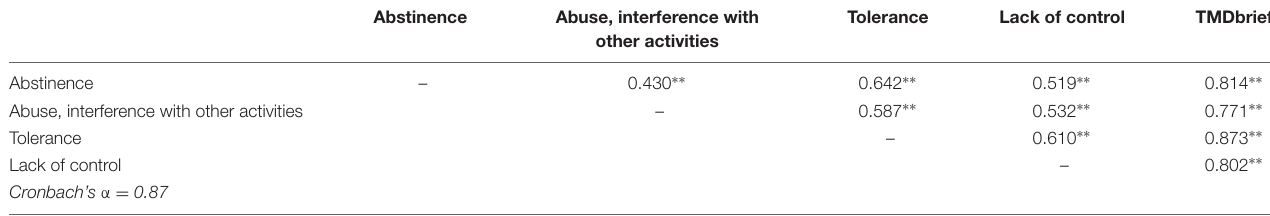
TABLE 8 | Factor correlation matrix (India).